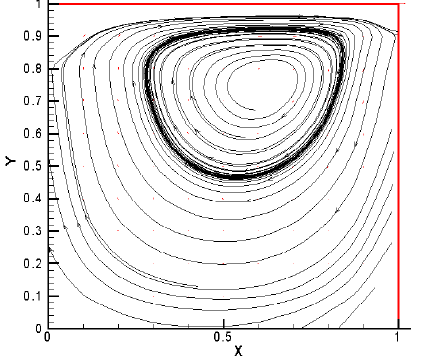
Figure 2. Streamlines plot of cavity flow for Mesh = 11×11 & Re = 100 Figure 3. Streamlines plot of cavity flow for Mesh = 31×31 & Re = 100